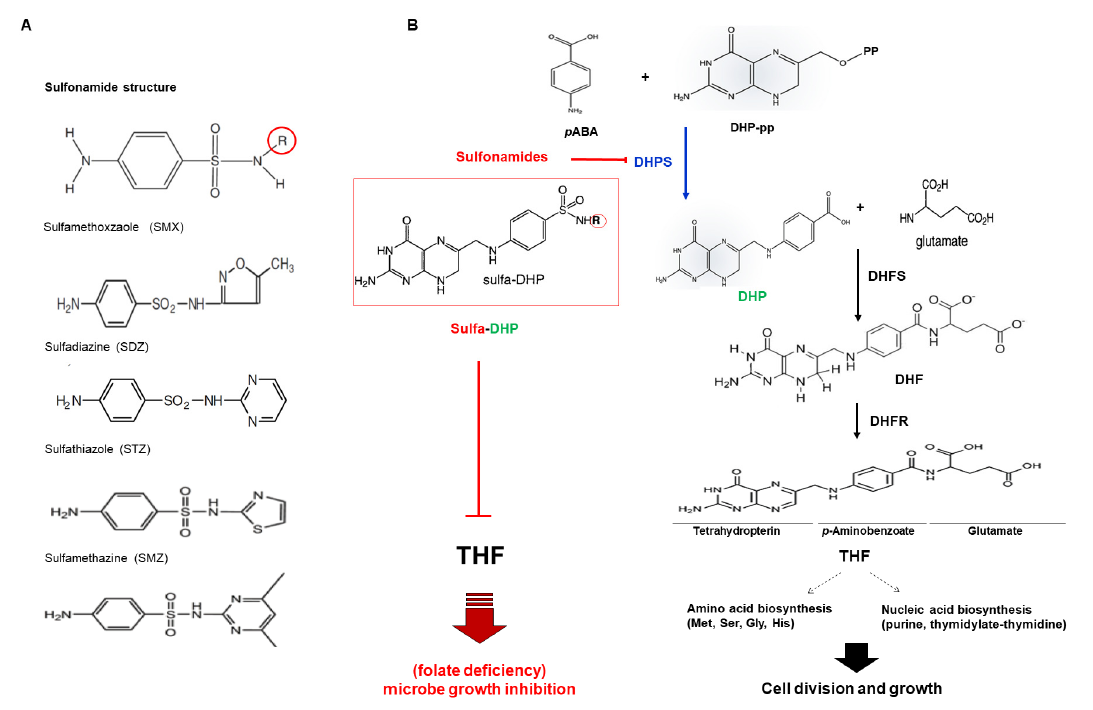
Figure 1. Folate biosynthesis inhibition by sulfonamide. ( A ) Sulfonamide structures: sulfamethoxazole (SMX), sulfadiazine (SDZ), sulfathiazole (STZ), sulfamethazine (SMZ). ( B ) Tetrahydrofolate (THF) biosynthesis inhibition by sulfonamide. Pyrophosphorylated DHP (DHP-pp)